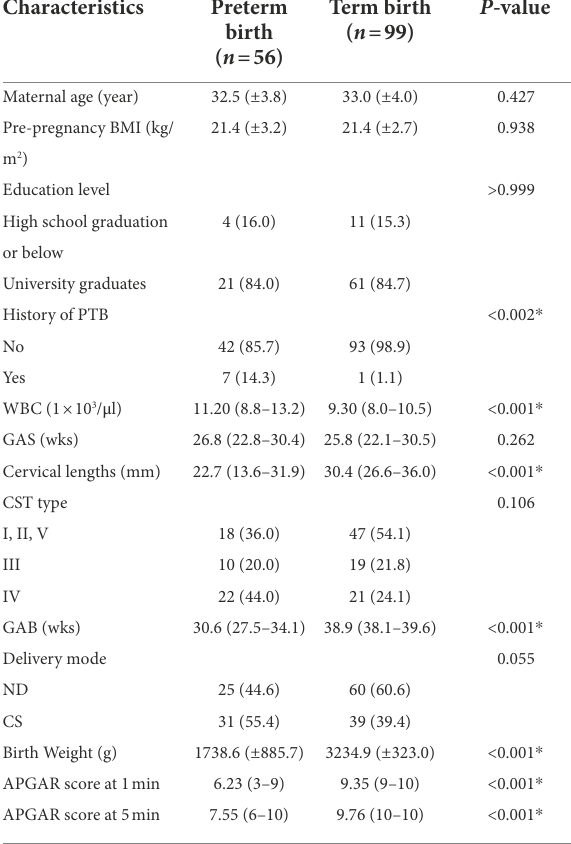
TABLE 1 Clinical characteristics of the study subjects.